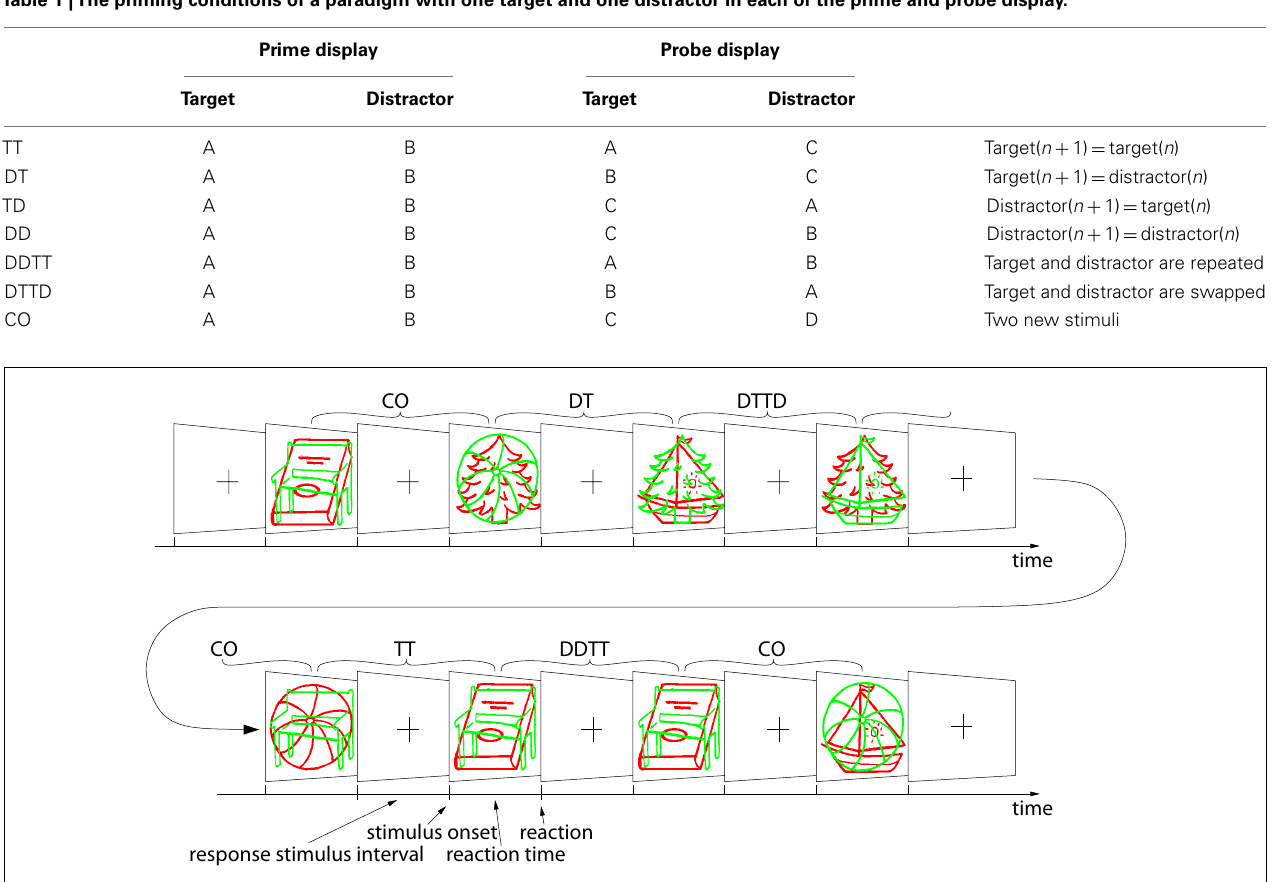
Table 1 |The priming conditions of a paradigm with one target and one distractor in each of the prime and probe display.